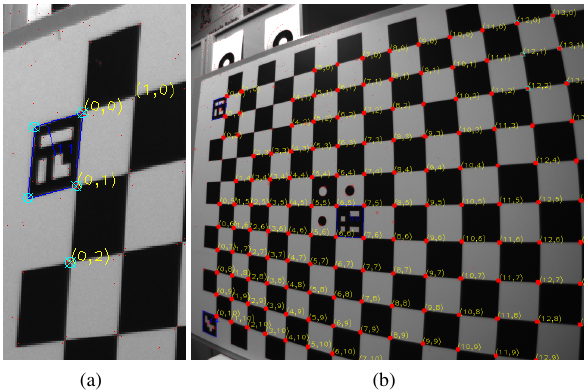
Figure 3: (a) Estimation of the image coordinate of point (1, 0) using the corners of the AprilTag and three already assigned points (light blue circles). (b) Result of the corner assignment been found and assigned automatically the calibration can be per- formed using a bundle adjustment, as described in the